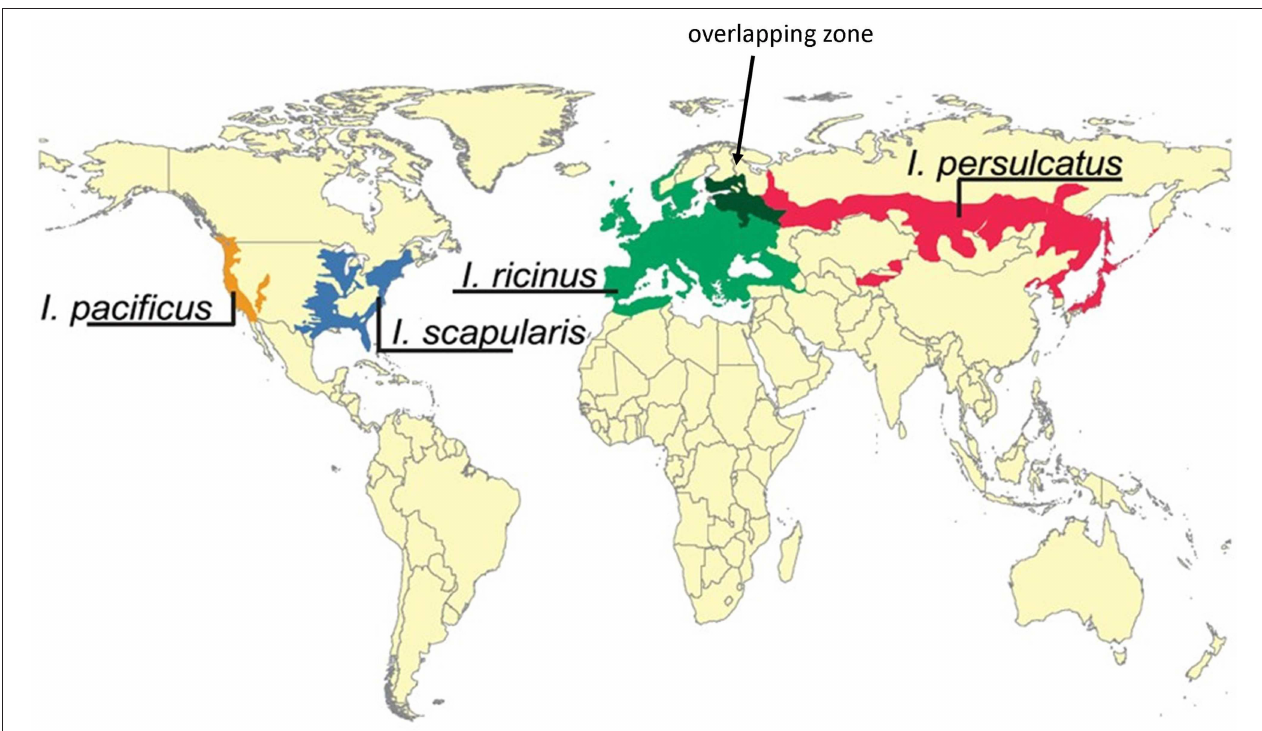
FIGURE 5 | Geographic distribution of main Borrelia vectors Ixodes persulcatus, Ixodes ricinus, Ixodes scapularis, and Ixodes pacificus . Note the overlapping region of I. persulcatus and I. ricinus (dark green zone indicated by an arrow). Modified after and re-used with permission from Swanson et al. (2006), Coinfections Acquired from Ixodes Ticks, Clin Microbiol Rev, 19, 708–727. These ticks have generalist feeding behaviors and serve as bridge vectors for agents of human Lyme borreliosis and are considered the most important vectors for Borrelia . They have—for the most part—distinct geographical distribution ranges and include I. pacificus (west of the Rocky Mountains) and I. scapularis (east of the Rocky Mountains, Northeast, Midwest and Southeast) in North America, I. ricinus in Europe and I. persulcatus in Eastern Europe and